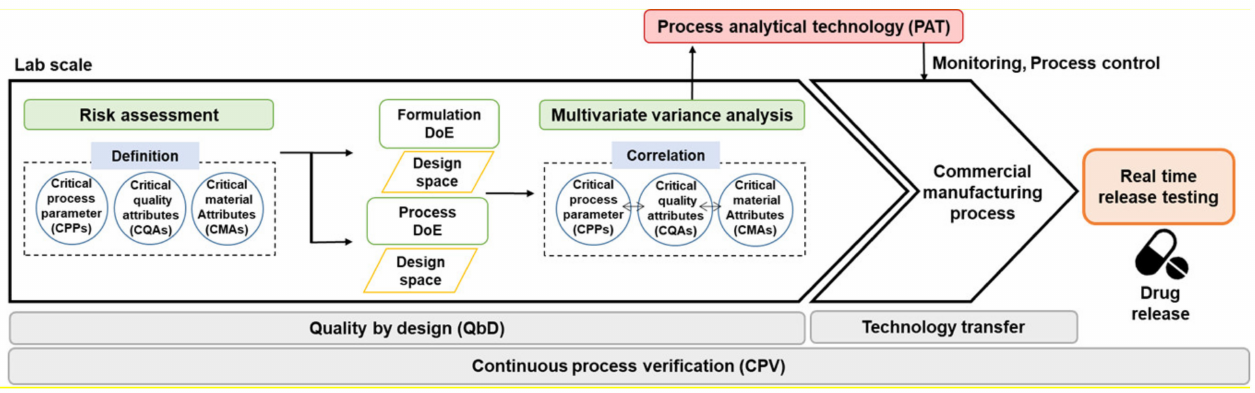
Figure 1. Framework of process analytical technology (PAT) application in quality by design (QbD)